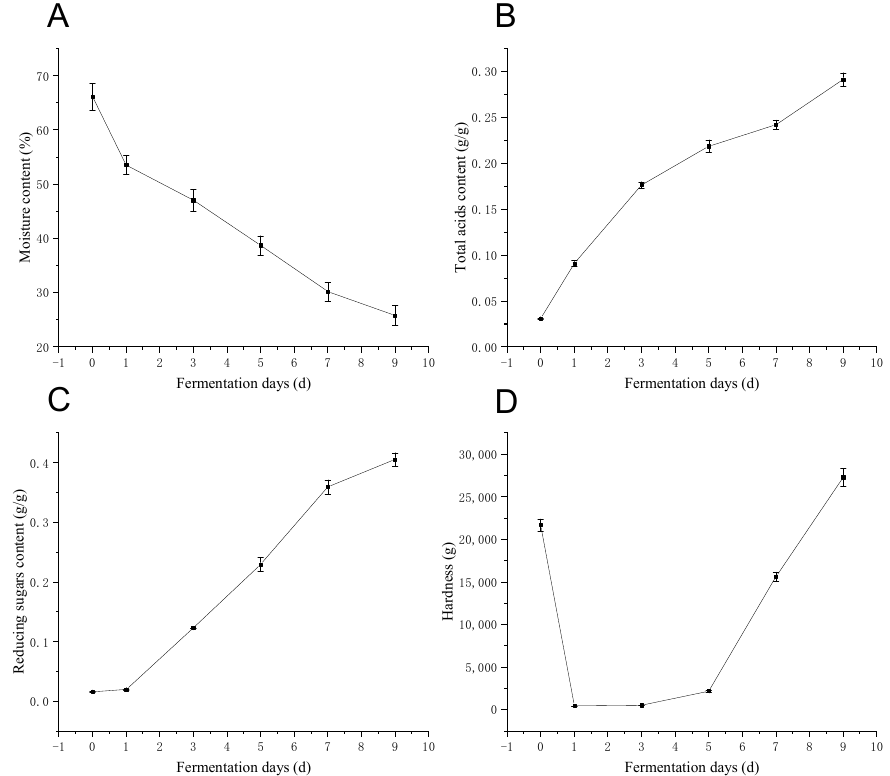
Figure 2. The change of moisture content ( A ), total acids content ( B ), reducing sugars content ( C ), and hardness ( D ) during BG fermentation. All data were expressed as mean ± standard deviation (SD).